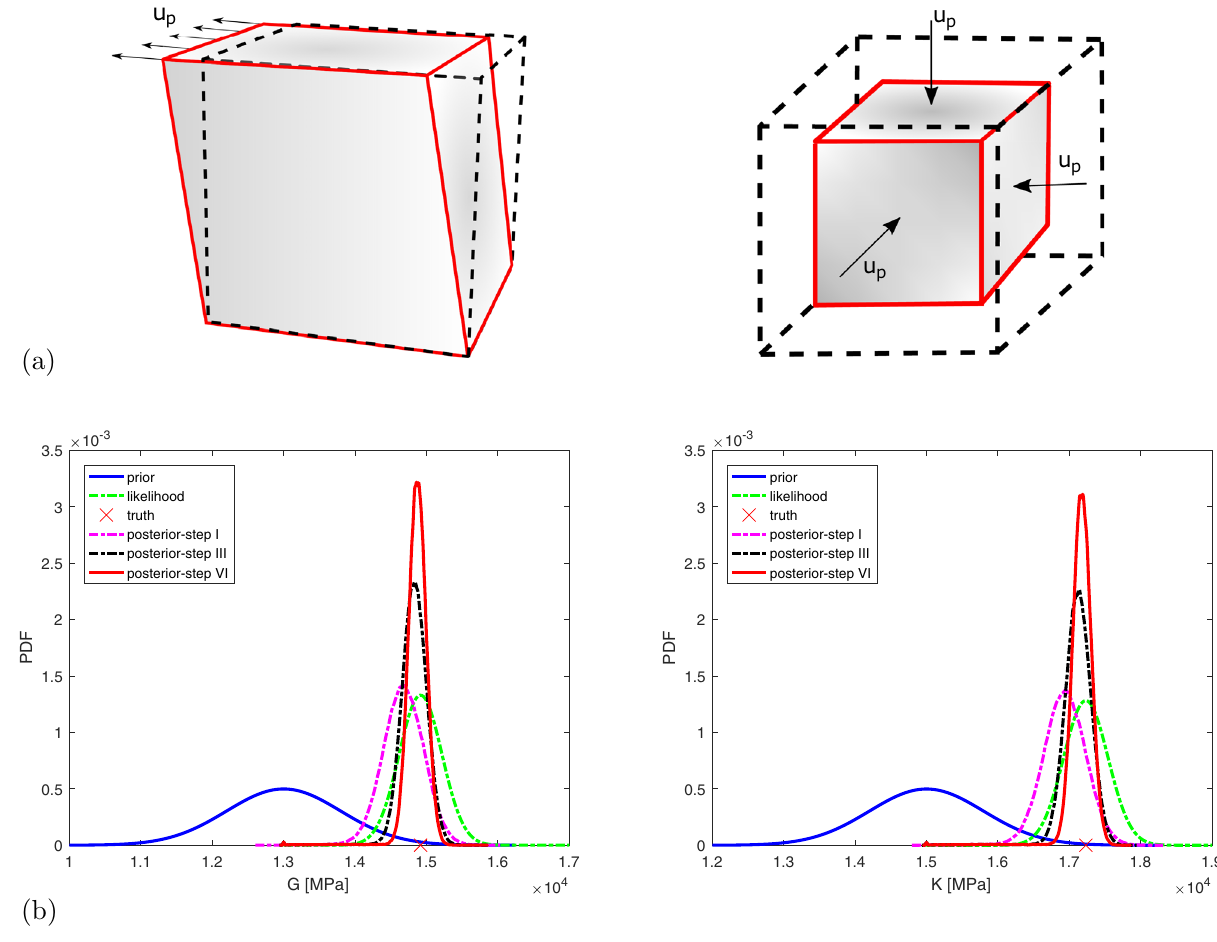
Fig. 14 a Stochastic homogenization RVE computations for shear modulus G and bulk modulus K ; b Bayesian inference computation results with the corresponding pdf for the shear modulus G ( 𝜔 ) and the bulk modulus K ( 𝜔